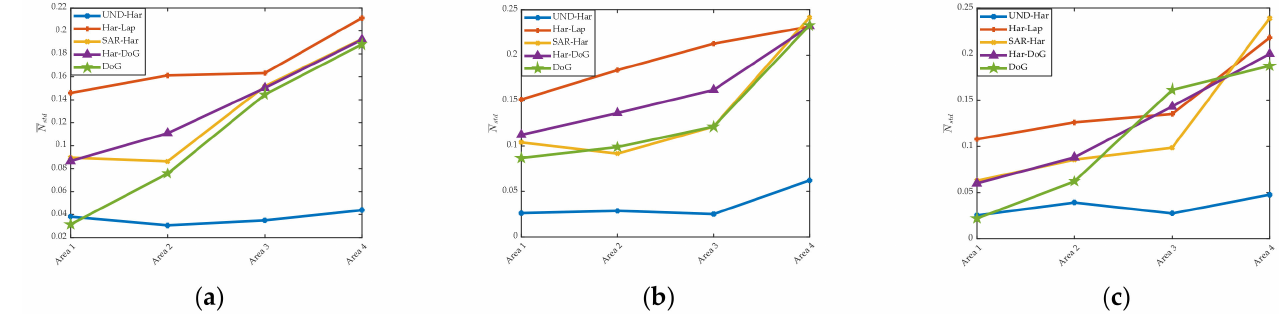
Figure 11. Distribution uniformity of interest points: ( a ) Spaceborne SAR-to-Airborne SAR.